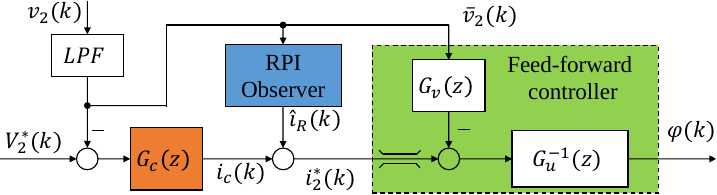
Figure 7. Control system